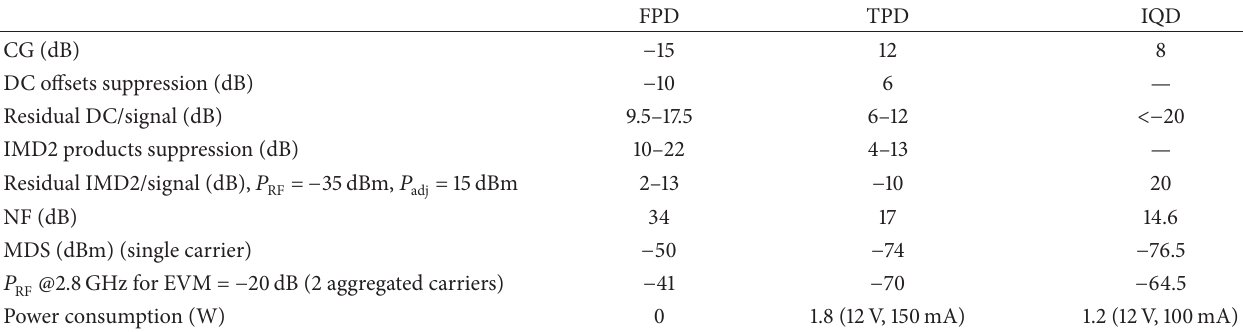
Table 2: Performance summary of FPD, TPD, and IQD architectures @2.8